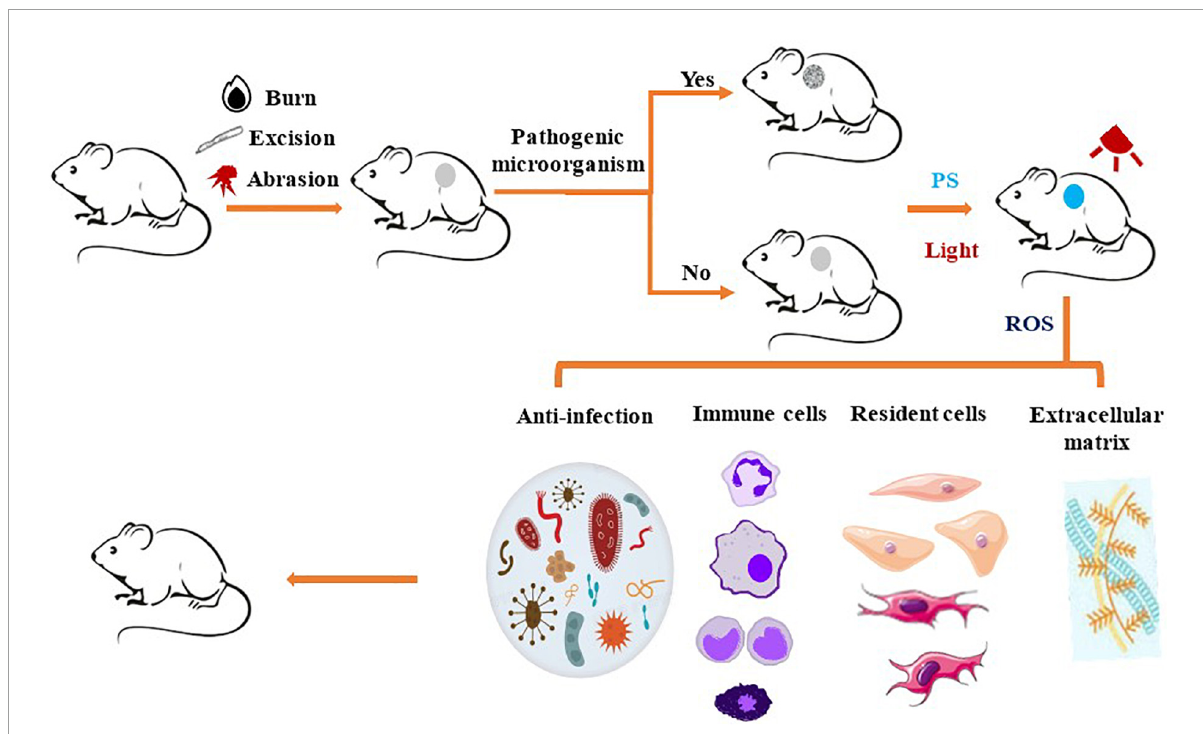
FIGURE3 Schematic representation of photosensitizer-based therapies in animal wound model. The animals receive a burn, excision, or abrasion wound, which is uninfected or infected by pathogenic microorganisms. Next, PS is applied to the wound, then irradiated with a light source that transfers energy to generate ROS or heat, which remove various pathogenic microorganisms from wound surface. PDT induced the recruitment of immune cells, such as neutrophils, mast cells, monocytes or macrophages, to the wound site, thereby promoting removal of the damaged tissue from the wound and induction of proinflammatory cytokines. PDT also stimulates skin resident cells to promote re-epithelialization and deposition of extracellular matrix to promote wound